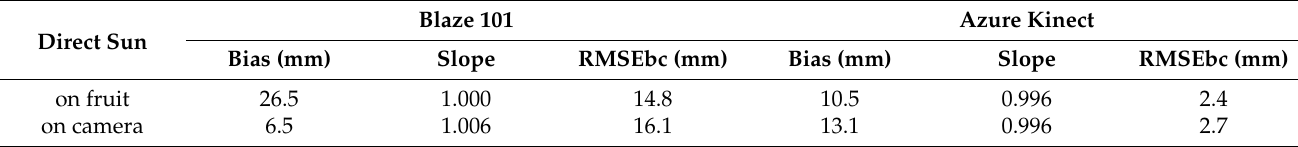
Table 3. Measurement of camera-to-fruit distance for 10 fruits under two lighting conditions for the Blaze 101 and Azure Kinect cameras. Measurements were made over a distance range of 0.5–2.0 m. RMSEbc refers to bias-corrected root mean square